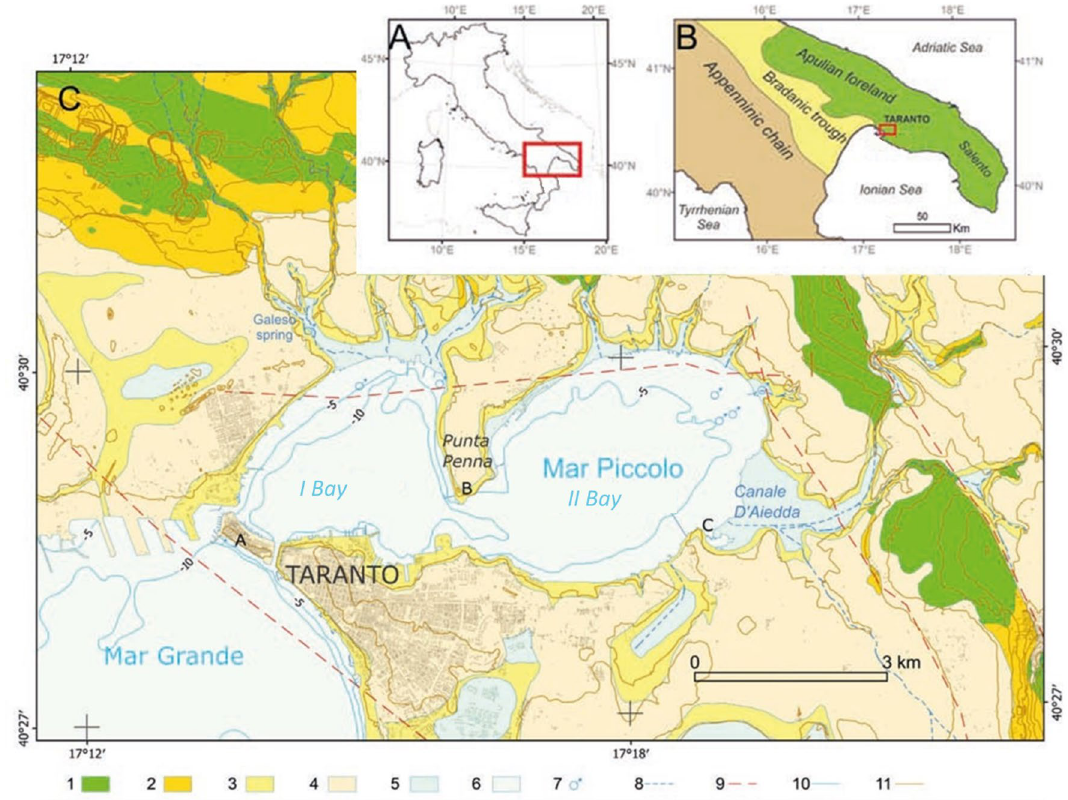
Figure 3. Geological map of the study area (C), whose location is shown in (A) and (B), modified after 29